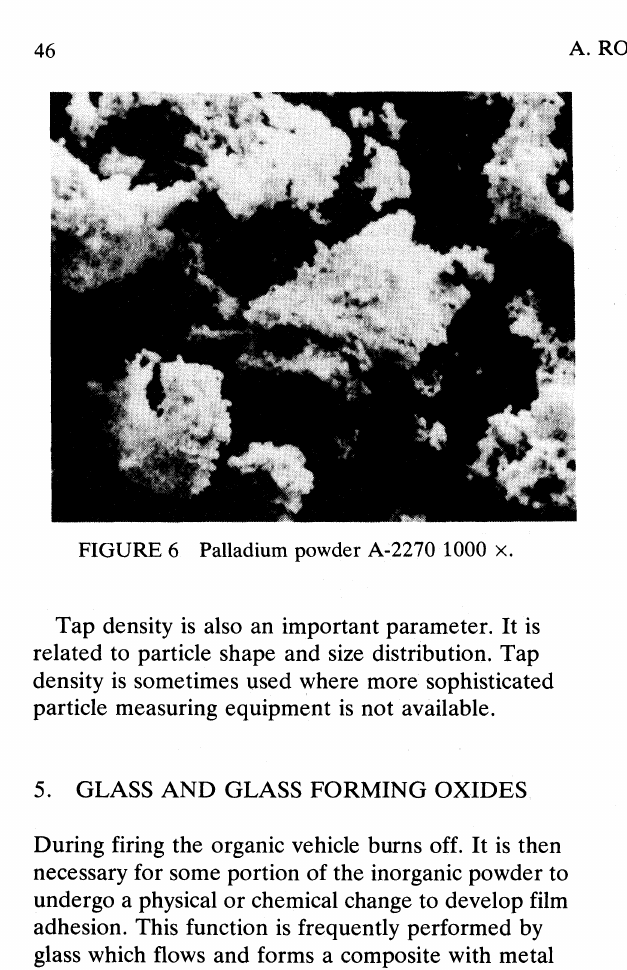
FIGURE 6 Palladium powder A’2270 1000